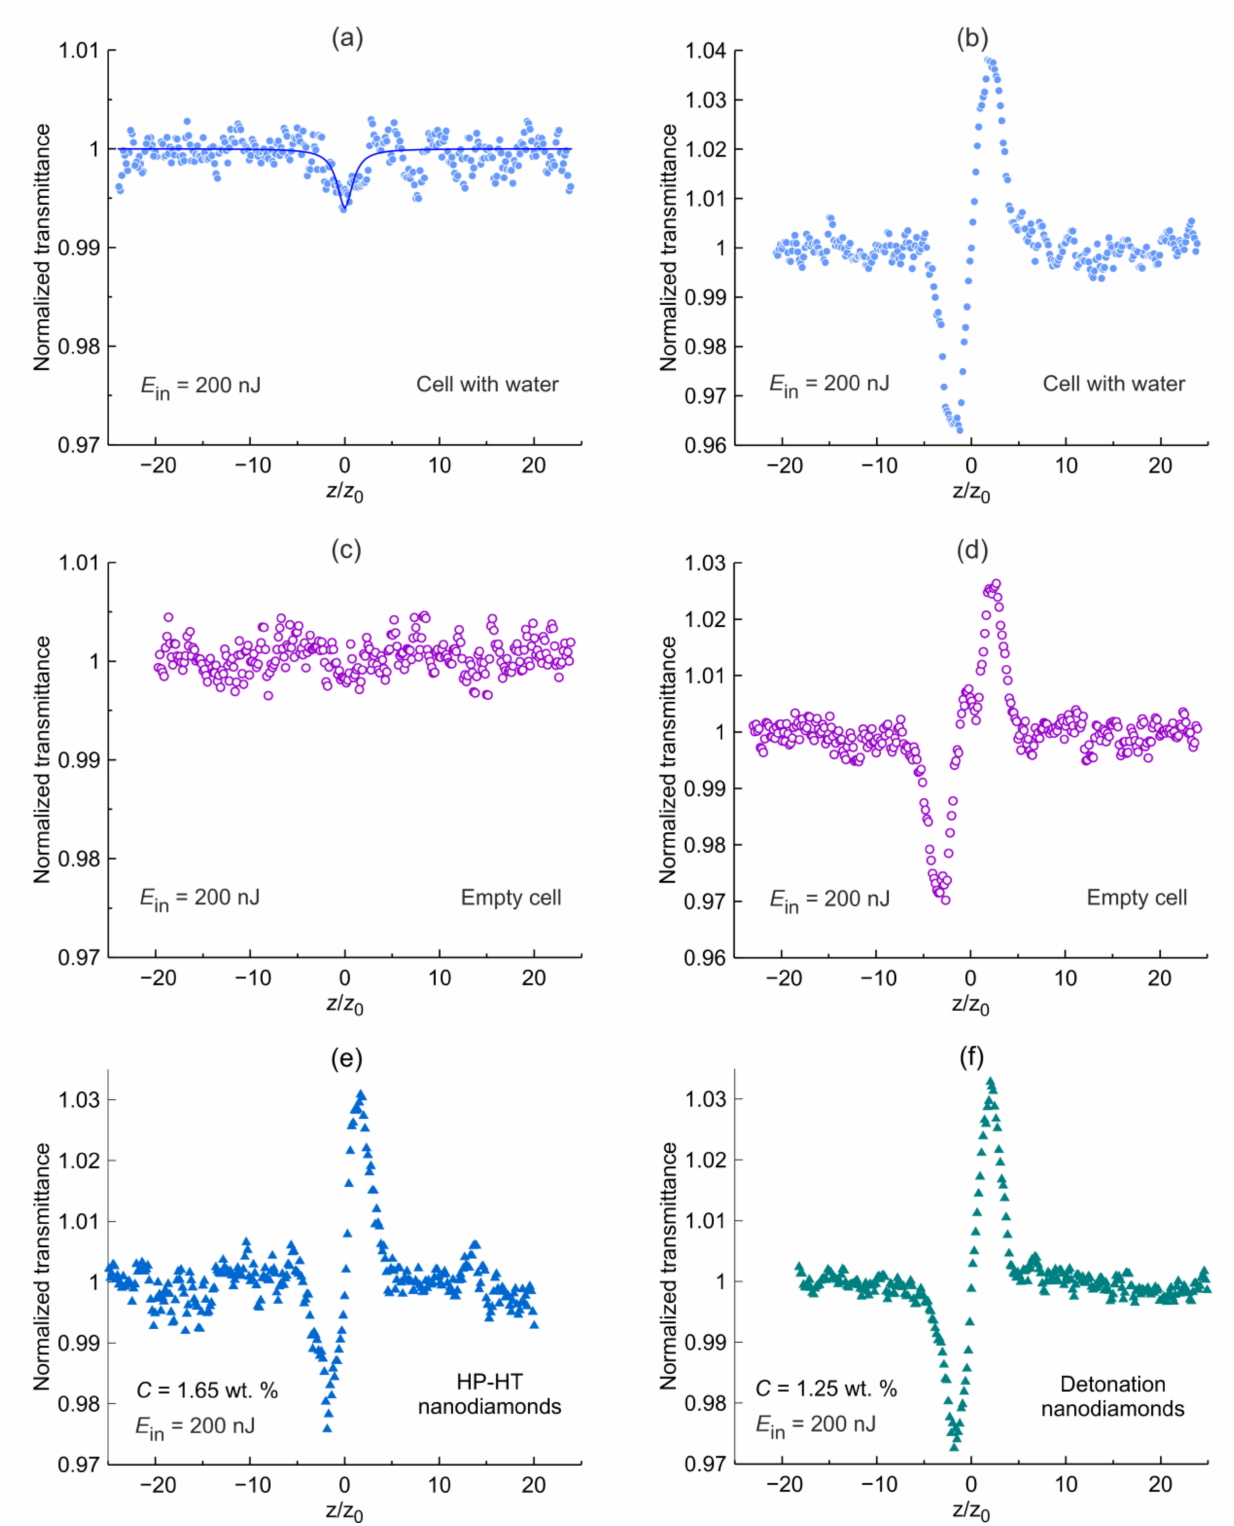
Figure 5. The normalized transmittance of the quartz cell with ( a ) distilled water and ( c ) an empty cell obtained in the open- aperture z-scan. The ratio of the nonlinear transmittance obtained in the closed to the data obtained in the open-aperture z-scan for the quartz cell ( b ) with distilled water, ( e ) with HP-HT nanodiamond suspension, ( f ) with detonation nanodiamond suspension, and ( d ) an empty cell. The measurements were performed at the incident laser pulse energy of 200